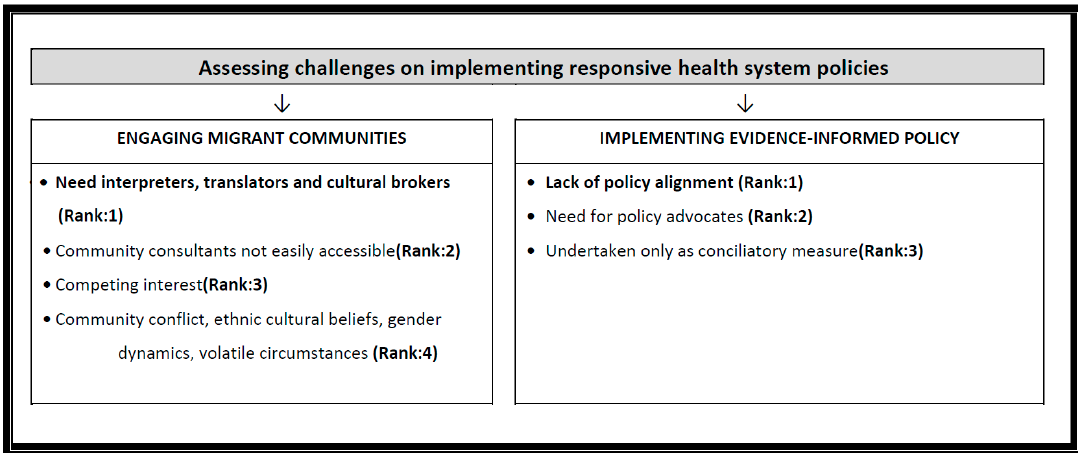
Figure 4. Priority ranked results on responsive health system implementation challenges.